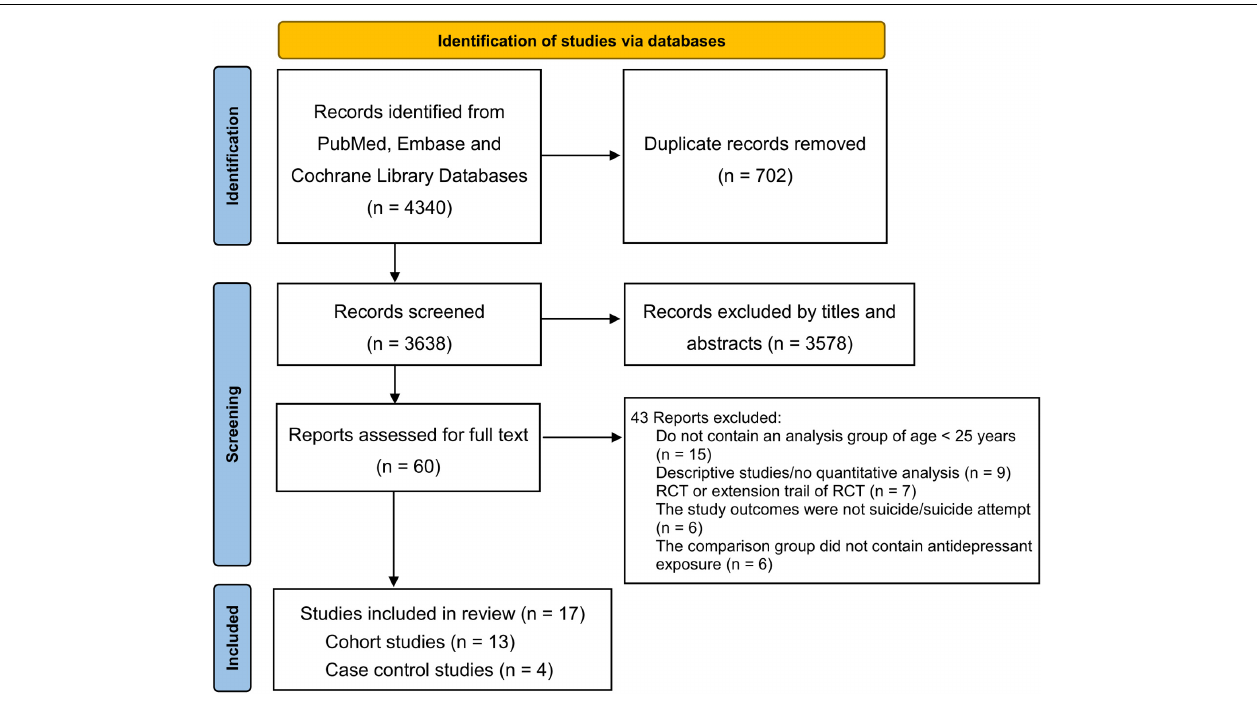
FIGURE 1 | Flow diagram of literature search and study